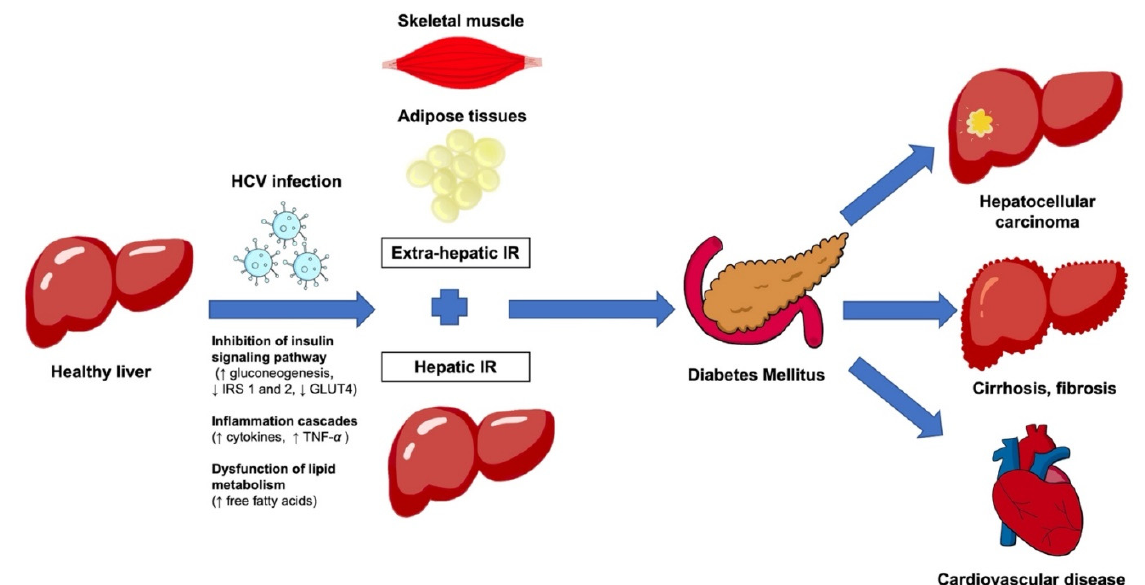
Figure 2. illustrates the mechanisms associated with HCV infections which lead to hepatic insulin resistance and extrahepatic insulin resistance in skeletal muscles and adipose tissues, which can cause diabetes mellitus and tissue injury associated with hyperglycemia. The chronic inflammation associated with viral infection and insulin resistance can lead to liver fibrosis, cirrhosis, and hepa- tocellular carcinoma. In addition, some patients develop cardiovascular disease. HCV, hepatitis C virus; IR, insulin